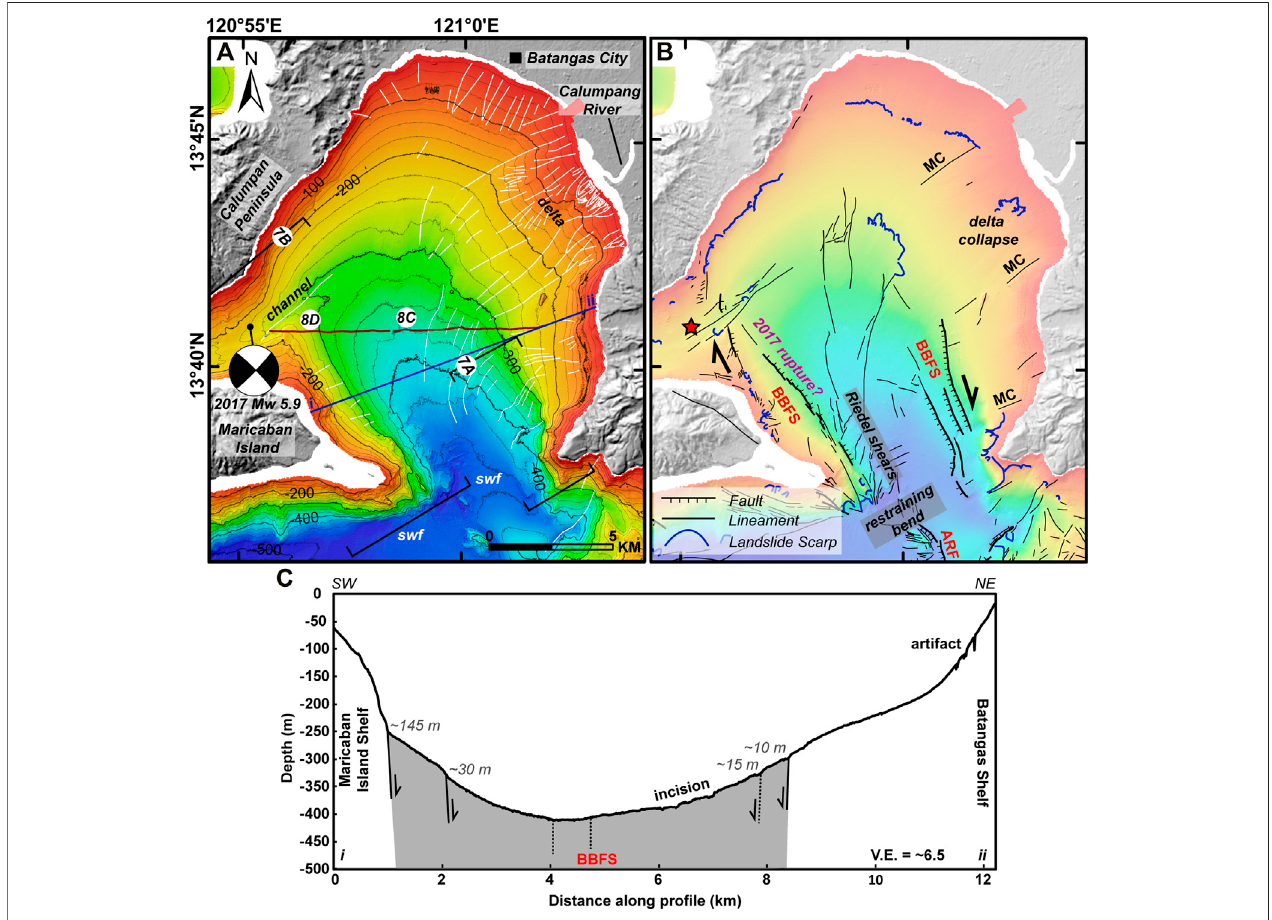
FIGURE 6 | Sea fl oor morphology of Batangas Bay. (A) Bathymetry of Batangas Bay. The mechanism (GCMT) and location (PHIVOLCS) for the 2017 earthquake are shown for reference. Isobaths are every 25 m. Brackets show locations of succeeding fi gures. Subbottom pro fi les are in maroon. The bathymetric pro fi le for 6C is in blue. White lines indicate gullies. swf: sediment wave fi eld. (B) Interpreted faults, lineaments, and landslide scarps. The epicenter of the 2017 earthquake is shown as a redstar. (C) Abathymetricpro fi leinBatangasBaywithscarpheightvalues.BBFS,BatangasBayFaultSystem;ARF,AglubangRiverFault;MC,MacolodCorridor.